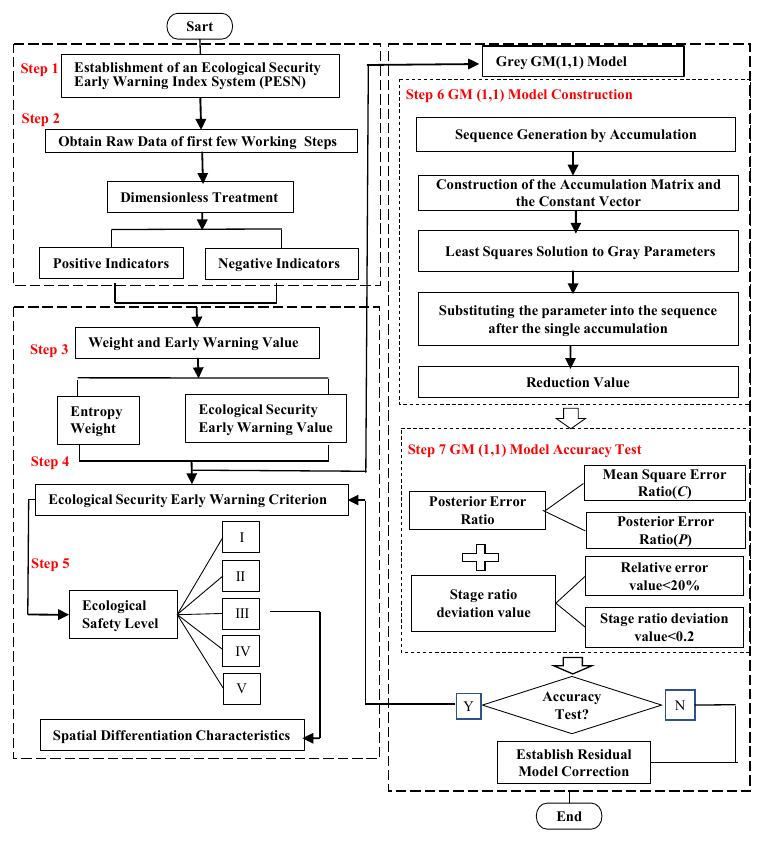
Figure 2. Model flow